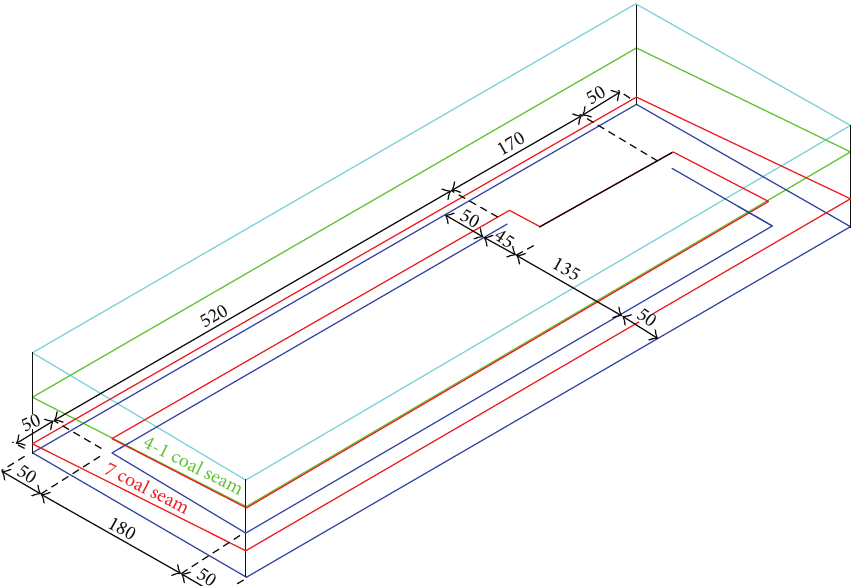
Figure 1: Numerical calculation model of south third 408 working face.